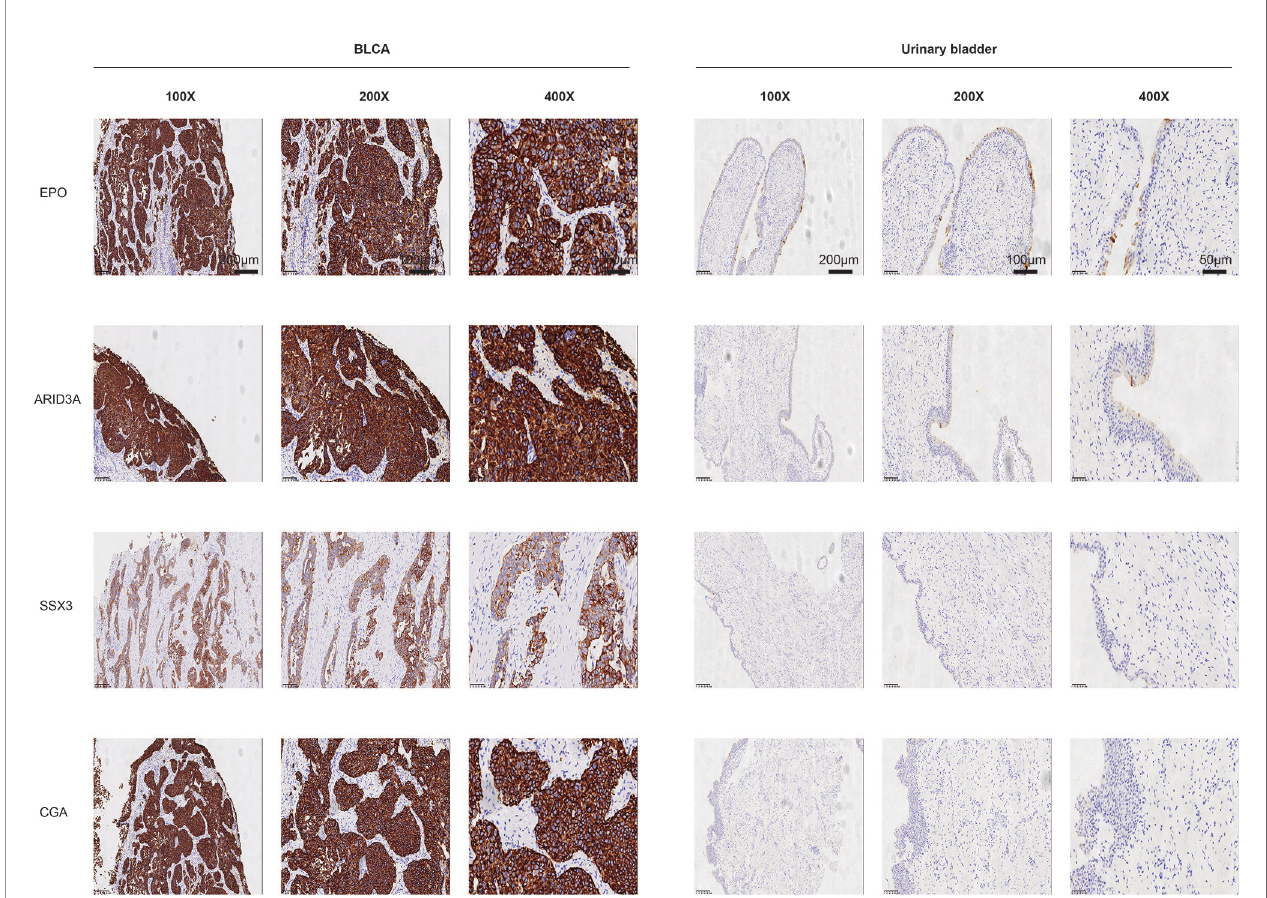
FIGURE 10 | The protein levels of key TFs and PRSGs in BLCA and normal urinary